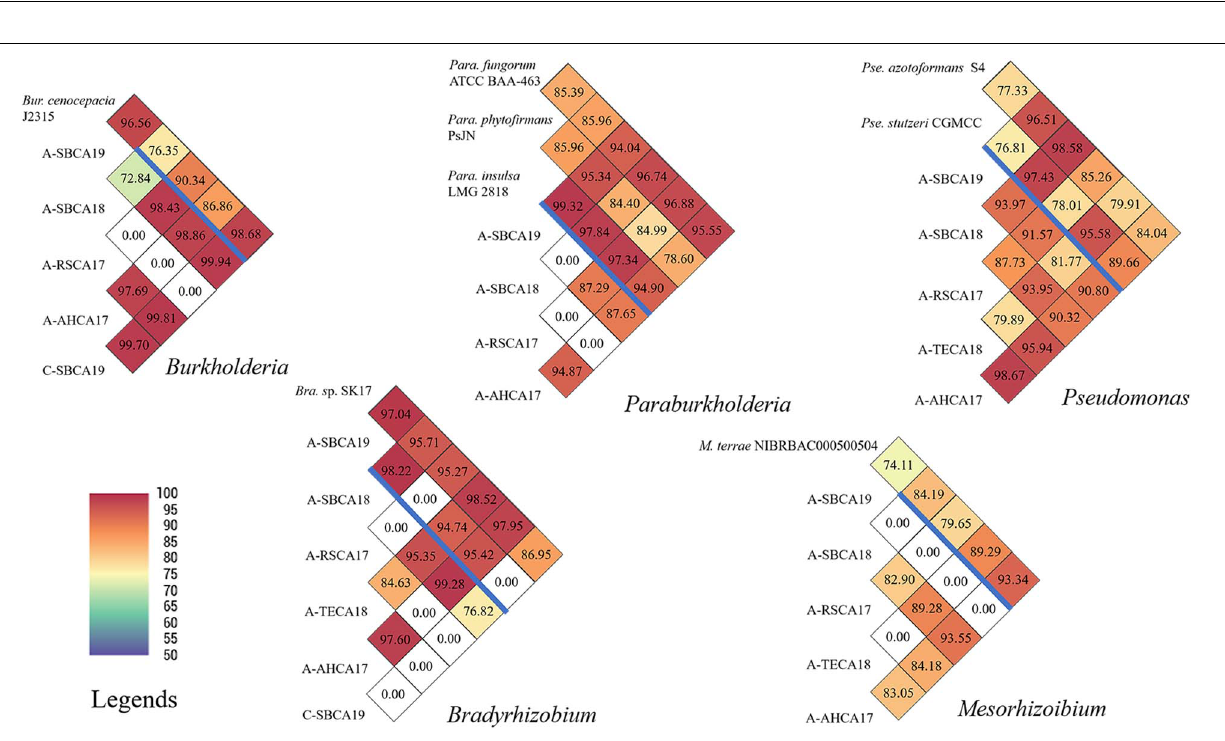
Frontiers in Microbiology |